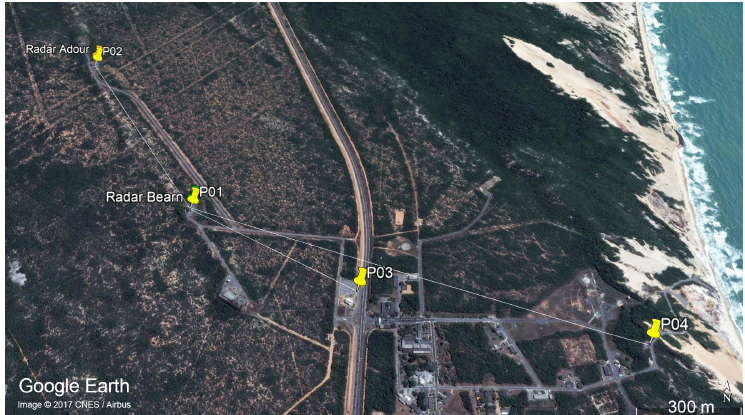
Figure 2. Location of measurement points.